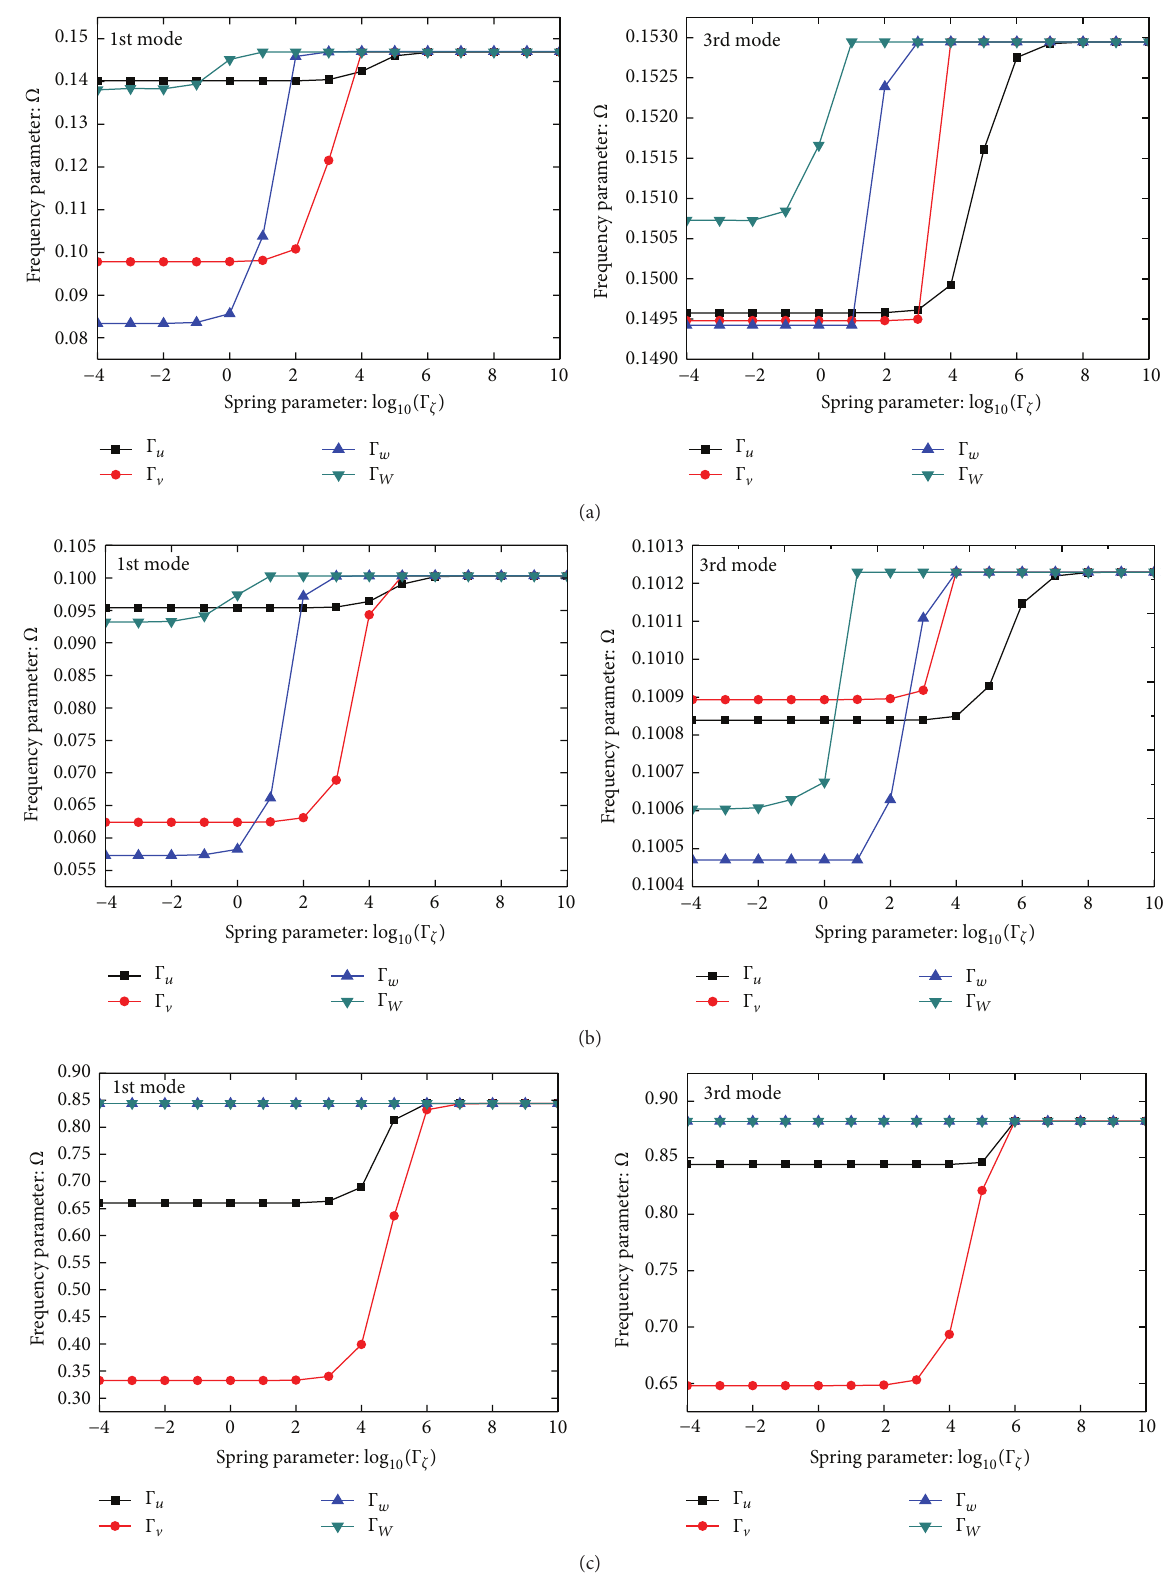
Figure 9: Effects of coupling spring stiffness on the 1st and 3rd frequency parameters Ω = 𝜔𝑅 √ 𝜌(1 − 𝜇 2 )/𝐸 of shells with subtended angle = 360 ∘ subjected to C-C boundary conditions: (a) cylindrical shell, (b) conical shell, and (c) spherical 𝜃 0